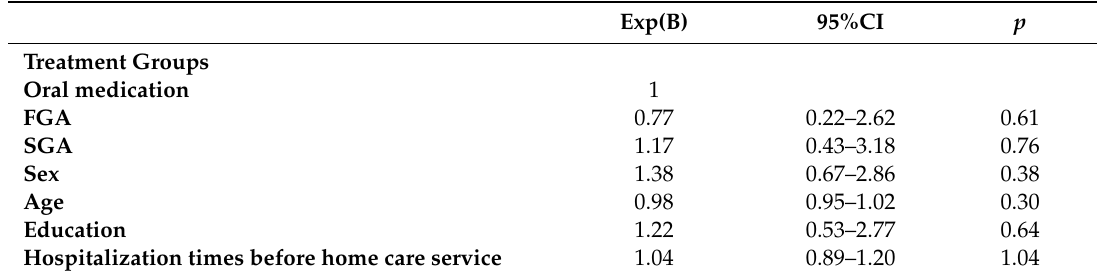
Table 3. The e ff ect of a di ff erent treatment on rehospitalization using Cox